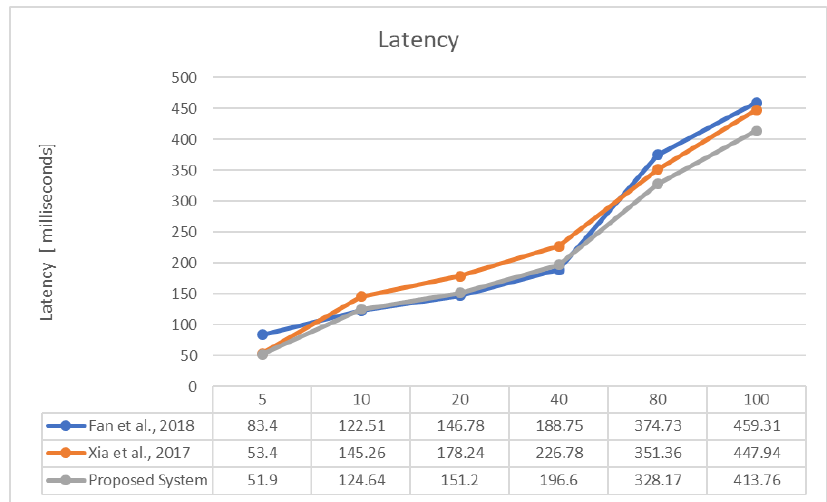
Figure 13. Comparison of the delay against the number of requests.